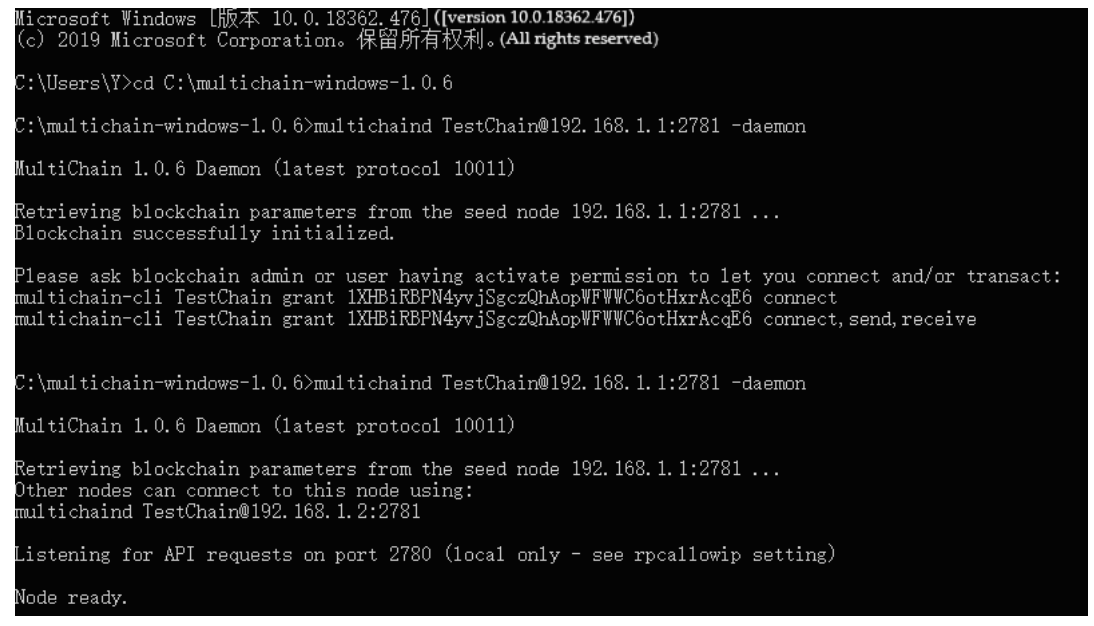
Figure A2. Making a connection request.